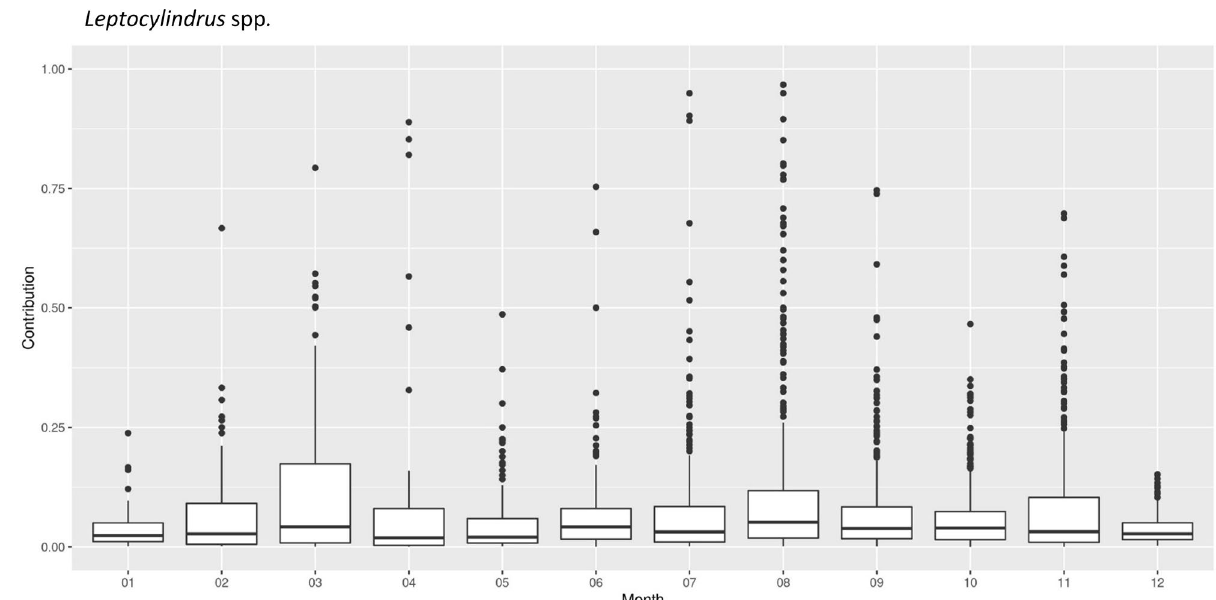
Figure 3. Box and whisker plot of the contributions of Leptocylindrus spp. throughout the year to the total microphytoplankton abundance for the years 1978–2020. Contribution is calculated as total microphytoplankton abundance divided by Leptocylindrus spp.